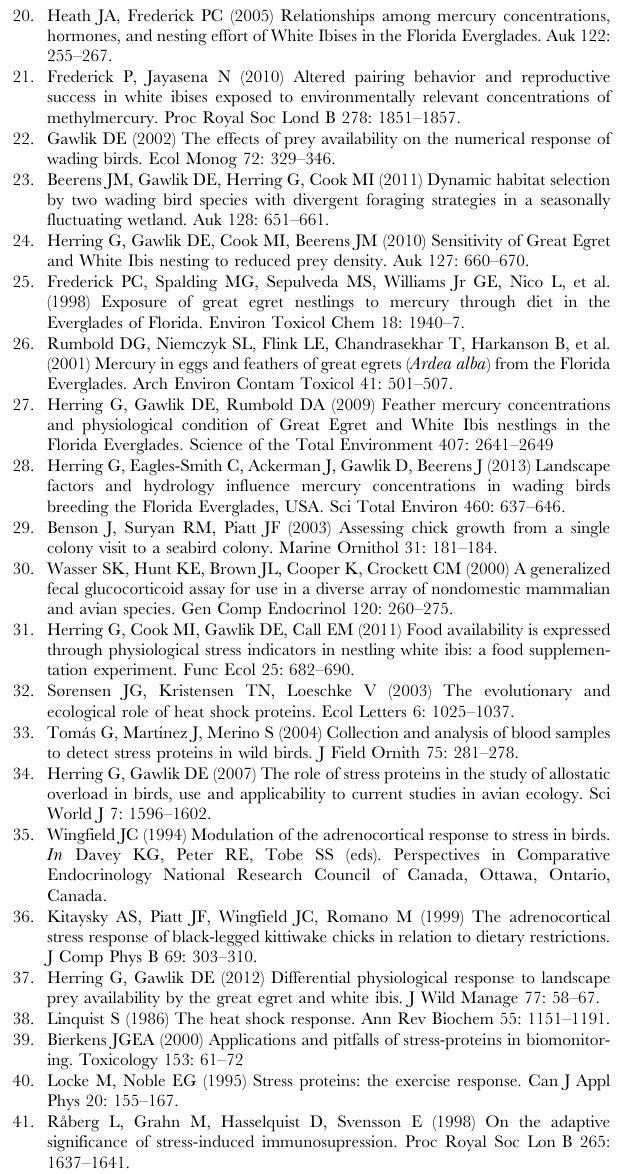
Figure S1 Location of study area indicating wading bird nesting colonies sampled during 2006 and 2007. The primary Water Management Areas (WCAs), Arthur R. Marshall Loxahatchee National Wildlife Refuge (Lox), and Everglades National Park (ENP) are indicated. Table S1 Data used in analyses of the Physiological con- dition of juvenile wading birds in relation to multiple landscape stressors in the Florida Everglades: effects of hydrology, prey availability, and mercury